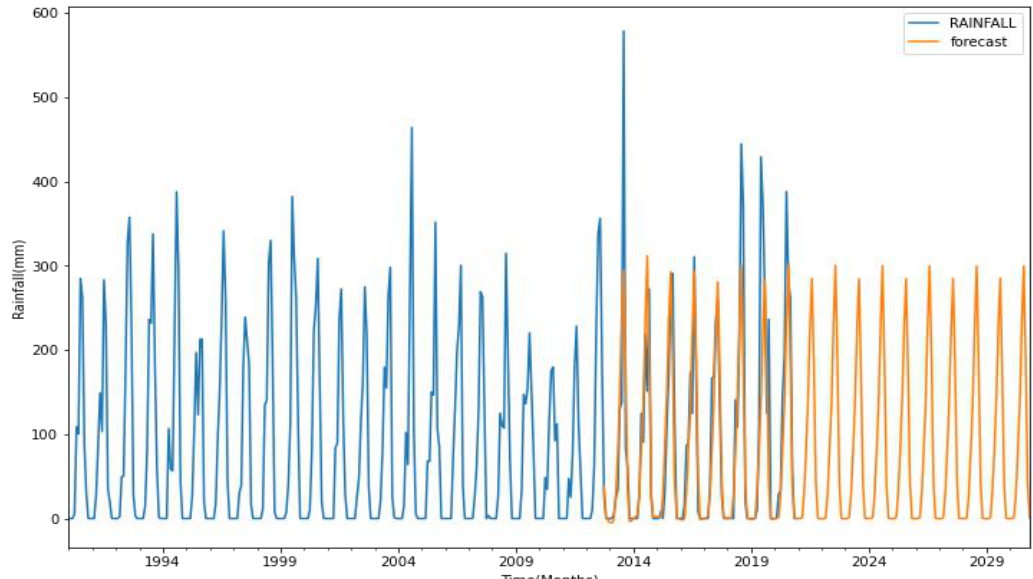
Figure 8: Forecast of the monthly Rainfall in Gombe Metropolis using ARIMA